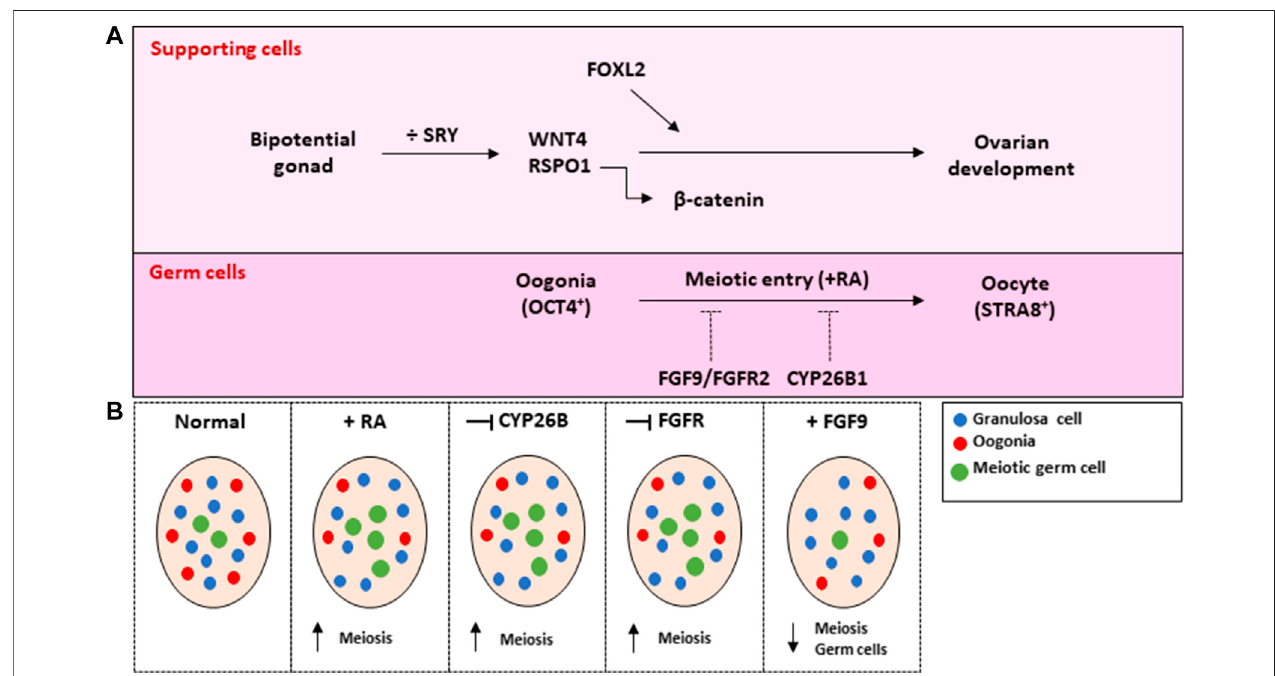
FIGURE1| Currentunderstandingofthesex-speci fi cdifferentiationofhumanfetalovariesbasedoninformationfrommousemodels,patientswithDisordersofsex development and ex vivo culture models. (A) In the bipotential gonad of a XX (female) embryo, absence of SRY and upregulation of pro-ovarian factors WNT4 and RSPO1 initiates the differentiation of the supporting cells to granulosa cells and thus ovarian fate through stimulation of the β -catenin signalling pathway. FOXL2 also plays an important role in the establishment and maintenance of granulosa cell identity. The somatic niche established by the granulosa cells promotes germ cell commitment to the female developmental pathway by supporting proliferation of oogonia as well as initiation of meiosis in a subset of oogonia through at least to some extendtheactionsofretinoic acid(RA)and expression ofSTRA8.Thisprocessisactivelyrepressedinanother subsetofoogoniabyFGF9 andCYP26B1. (B) Illustration and summary of fi ndings from the manipulation of selected signalling factors in ex vivo cultured human fetal ovaries. References to the studies included in the fi gure can be found in the text.